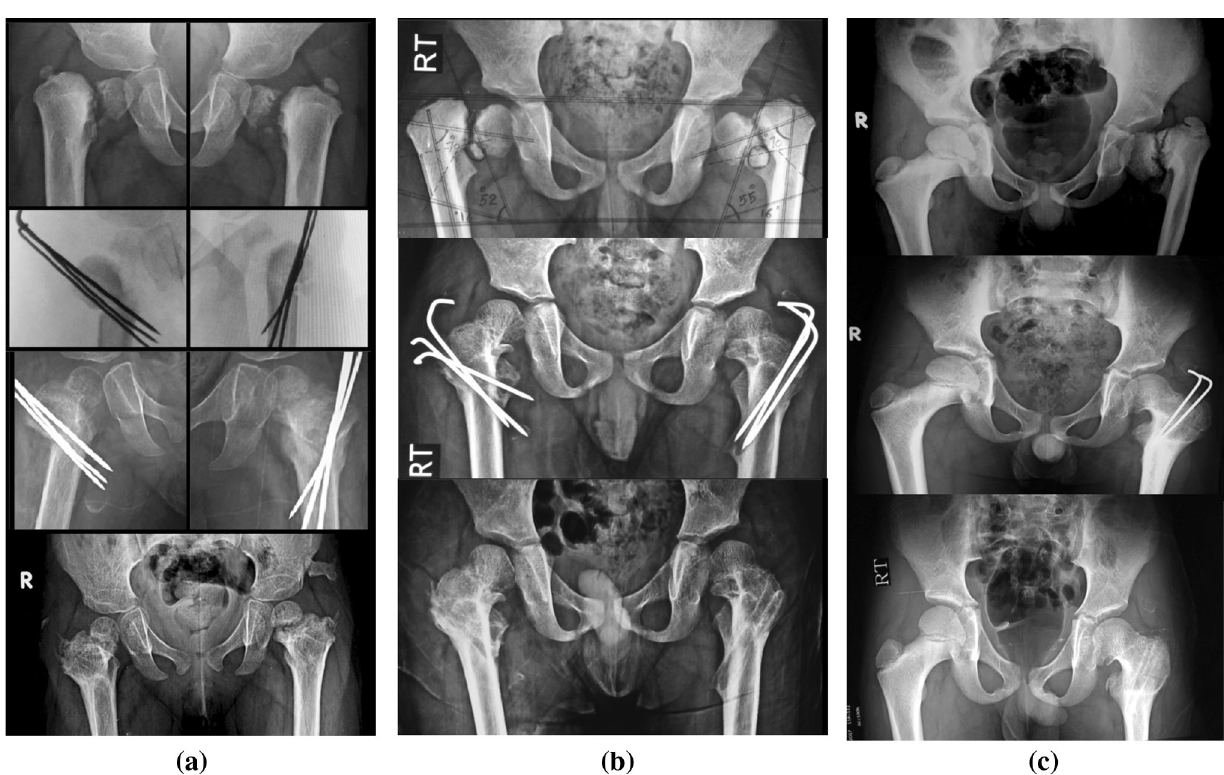
Fig. 7 Radiological results for three different cases in the study. a Good radiological results with satisfactory restoration of HEA and FNSA in a 2-year-old female with bilateral developmental coxa vara after removal of the transfixing wires. b Good radiological results with satisfactory restoration of HEA and FNSA in a 4-year-old male